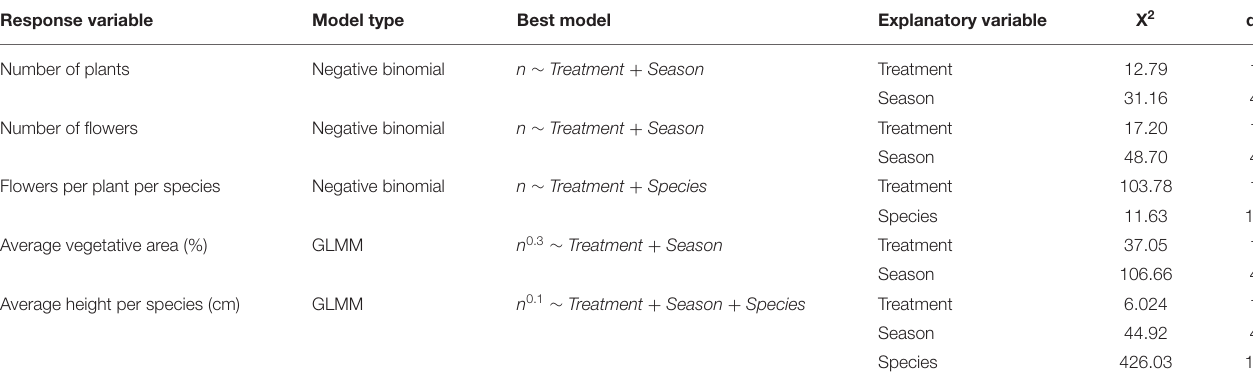
TABLE 1 | Effect of deer presence on vegetation over time using analysis of deviance (Type II